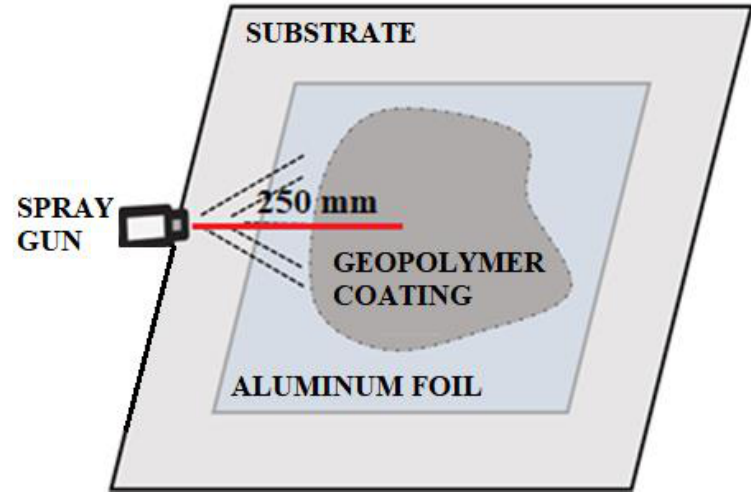
Figure 3. Scheme of applied material on aluminum foil.